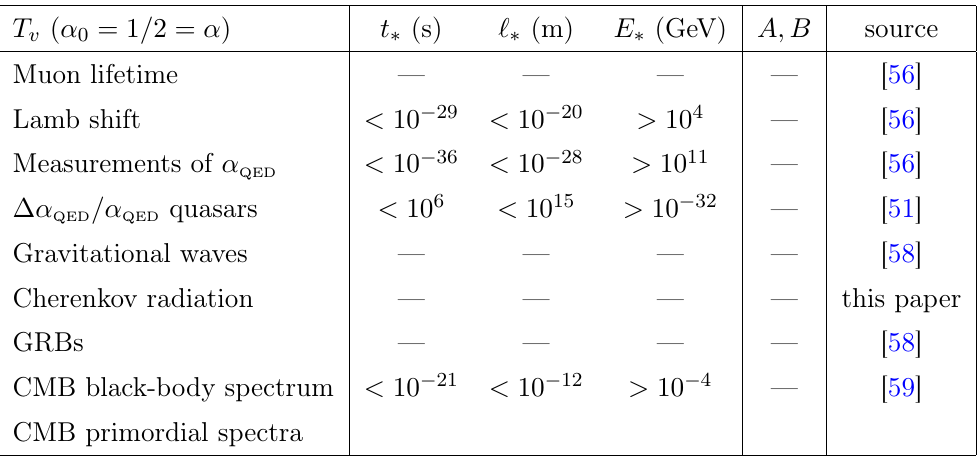
Table 5 . Bounds on the hierarchy of multifractional spacetimes with weighted derivatives for (cid:11) 0 = 1 = 2 = (cid:11) .